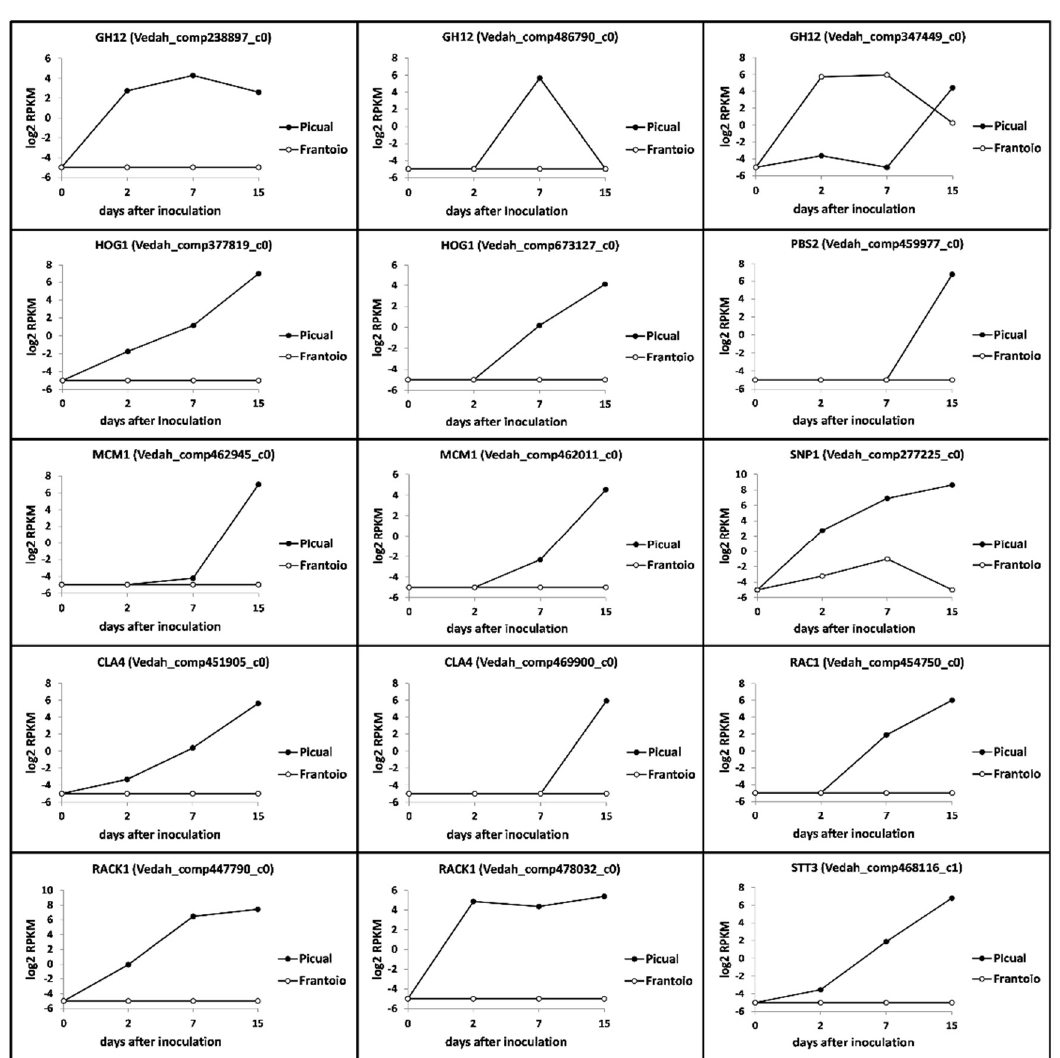
Figure 8. Verticillium dahliae unigenes related to phenotypes important during the parasitic phase and differentially expressed in ‘Picual’ and ‘Frantoio’ roots during infection. Samples were analyzed by RNAseq (see the Results section for details). RPKM, Reads Per Kilobase Million.